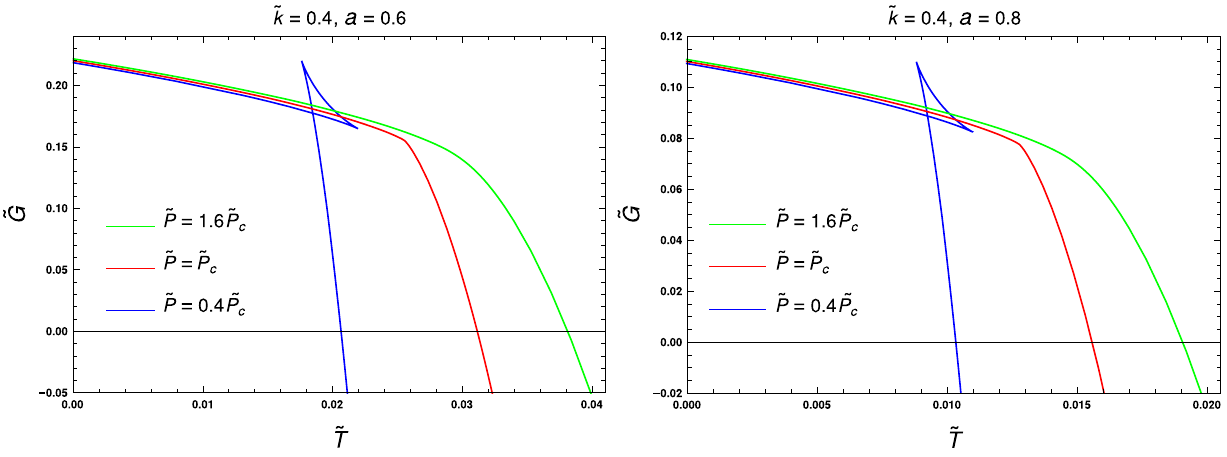
Fig. 6 The plot of Gibbs free energy ˜ G vs temperature ˜ T exhibiting a liquid–gas phase transition for ˜ P < ˜ P c and no transition for ˜ P > ˜ P c obtained for a particular value of a ( ˜ k ) and corresponding critical pres-